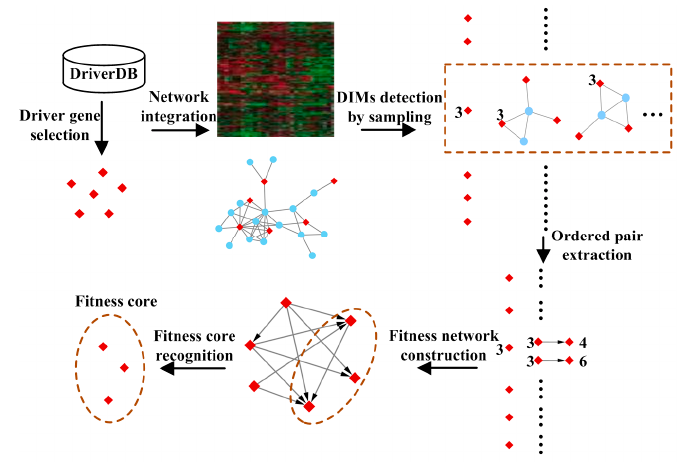
Figure 1. The schematic overview of the proposed framework. Driver genes are collected from DriverDB and a sampling strategy is designed to detect driver-induced modules (DIMs) by integrating gene expression data and network information. Then, fitness relationships among driver genes are extracted from DIMs, which are denoted as weighted ordered pairs. Genes indegree dominated are recognized as the fitness core by network analysis.